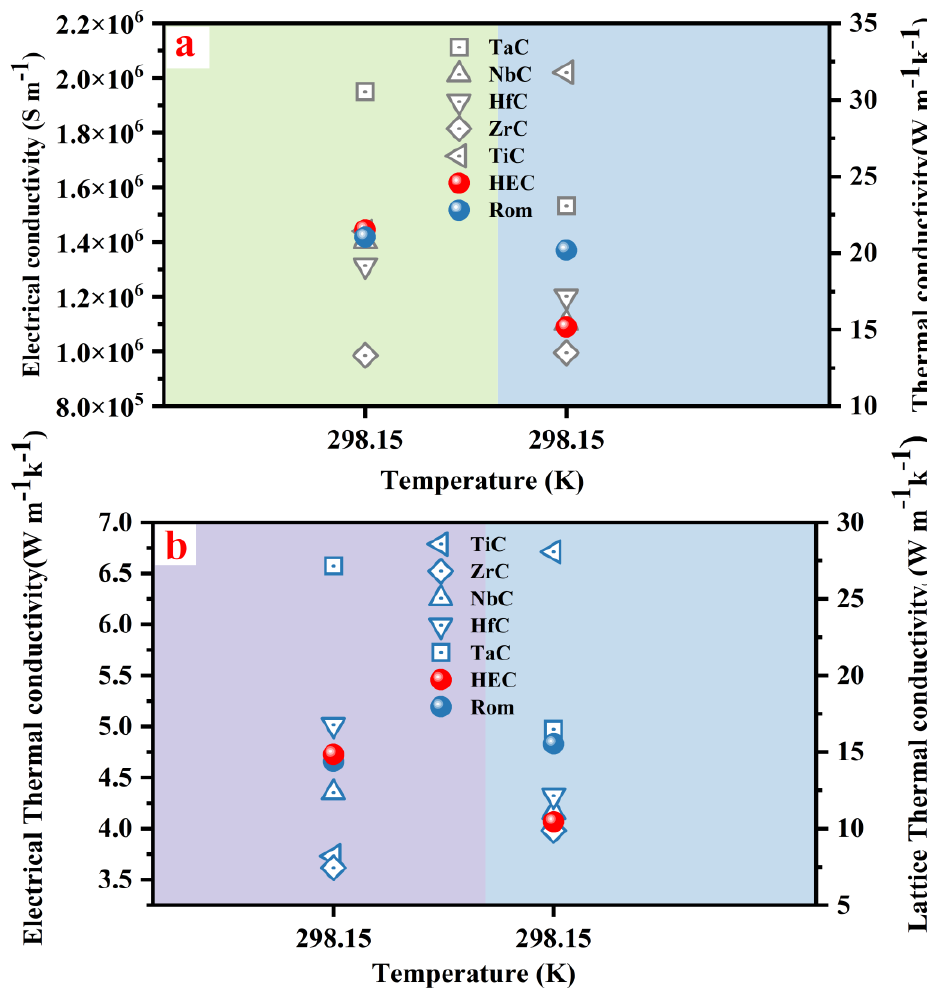
Figure 2. ( a ) Measured electrical and thermal conductivity of (Ti 0.2 Zr 0.2 Nb 0.2 Hf 0.2 Ta 0.2 )C (sintered at 1900 °C) and binary carbides (TiC, ZrC, NbC, HfC and TaC) referenced from Xin Liang’s report [32]; ( b ) the electrical thermal conductivity and lattice thermal conductivity for HEC and individual car−bides.